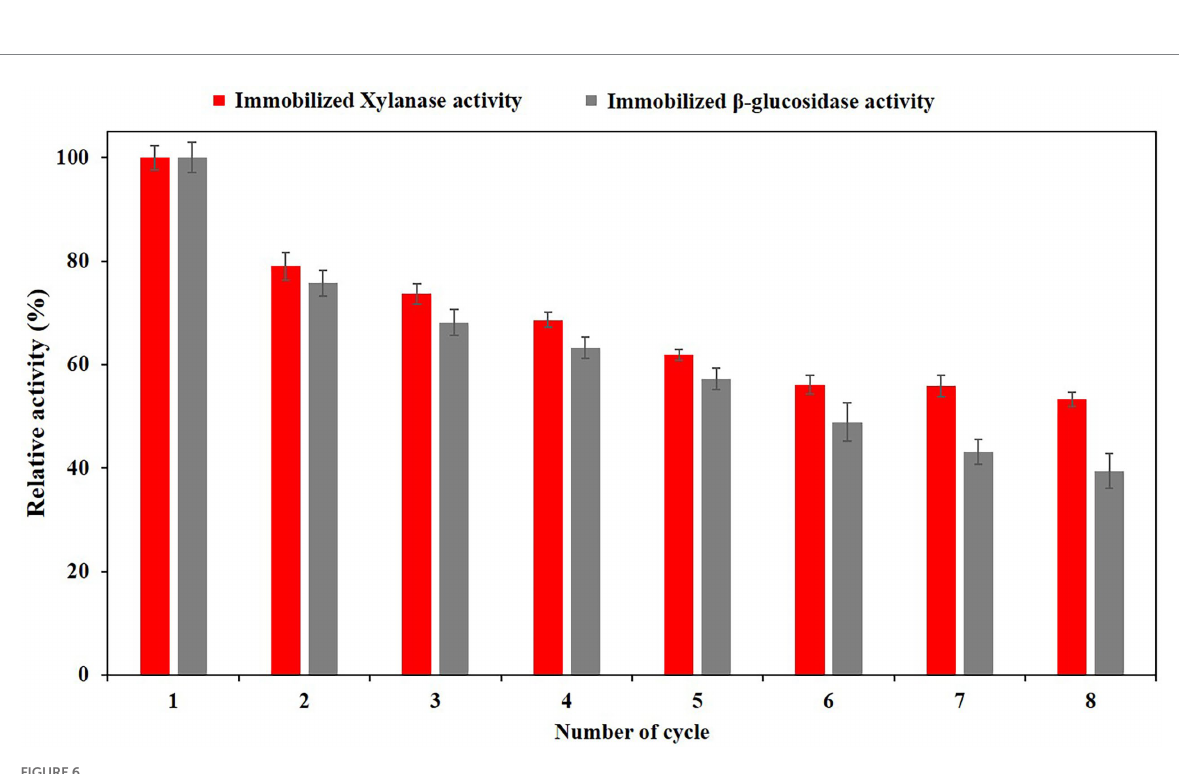
FIGURE 6 (A) Hydrolysis of the CRW by the free and immobilized PersiBGLXyn1 after 10 days at 50 ° C. (B) Bioethanol production from the CRW hydrolysates produced by the free and immobilized PersiBGLXyn1 during 3 days of